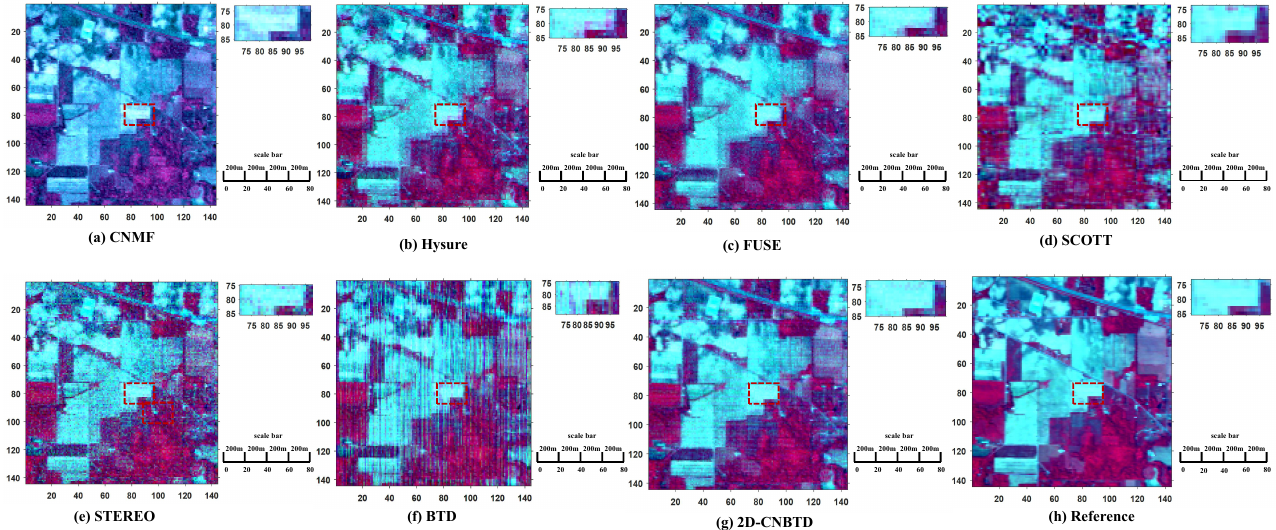
Figure 10. Graph of reconstructed HRHS results for Indian Pine dataset.